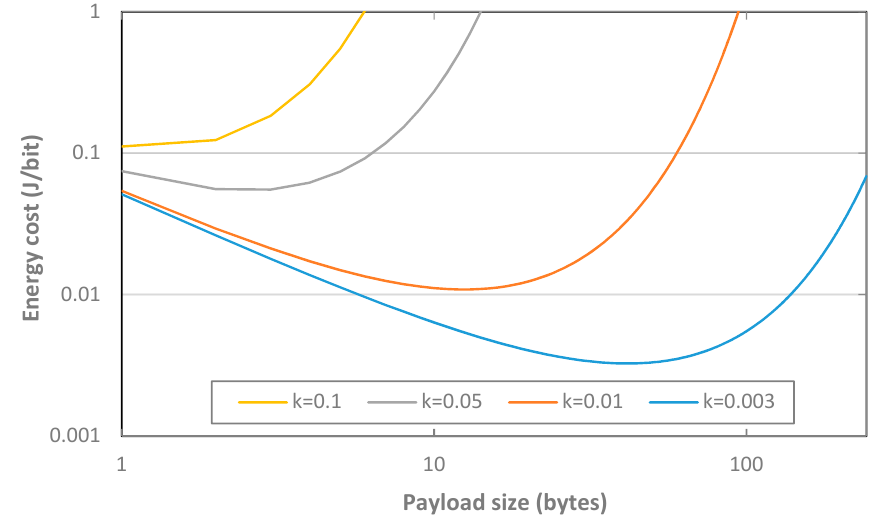
Figure 22. Impact of message payload, l pay , on the energy cost of data delivery, assuming a dense LoRaWAN network, for, α = 0.4 J and DR = 5.